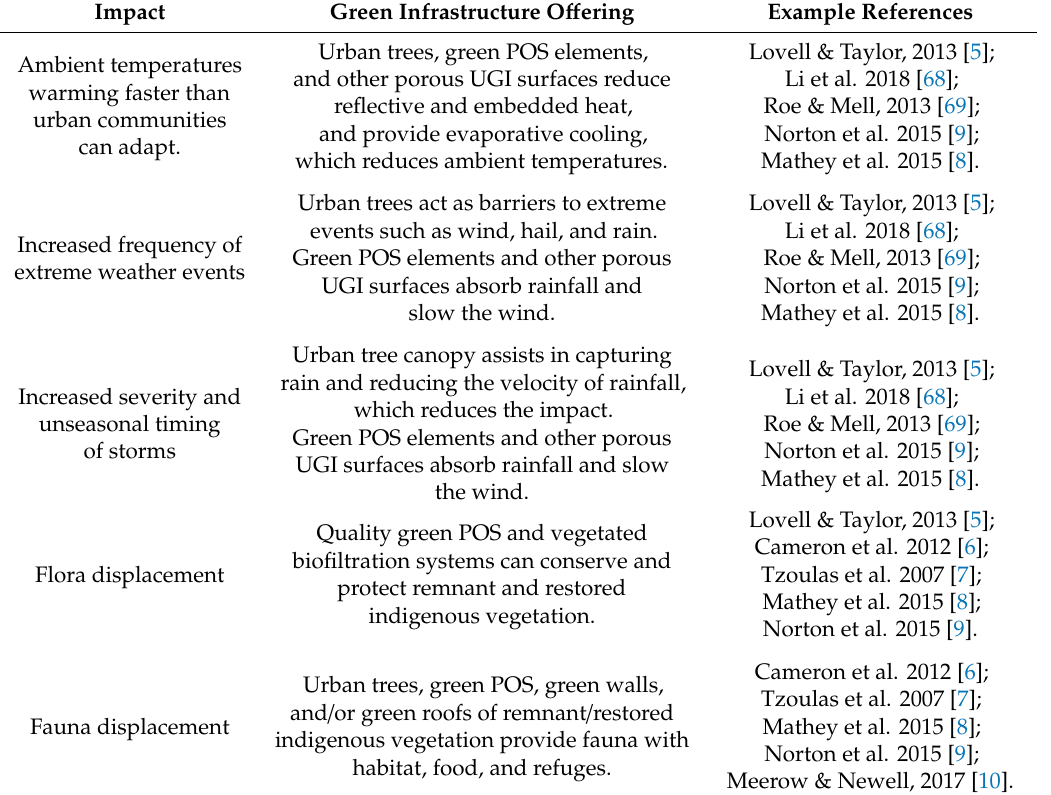
Table 1. Examples of urban green infrastructure o ff erings that could mitigate and / or meditate impacts arising from the crisis of climate change on urban